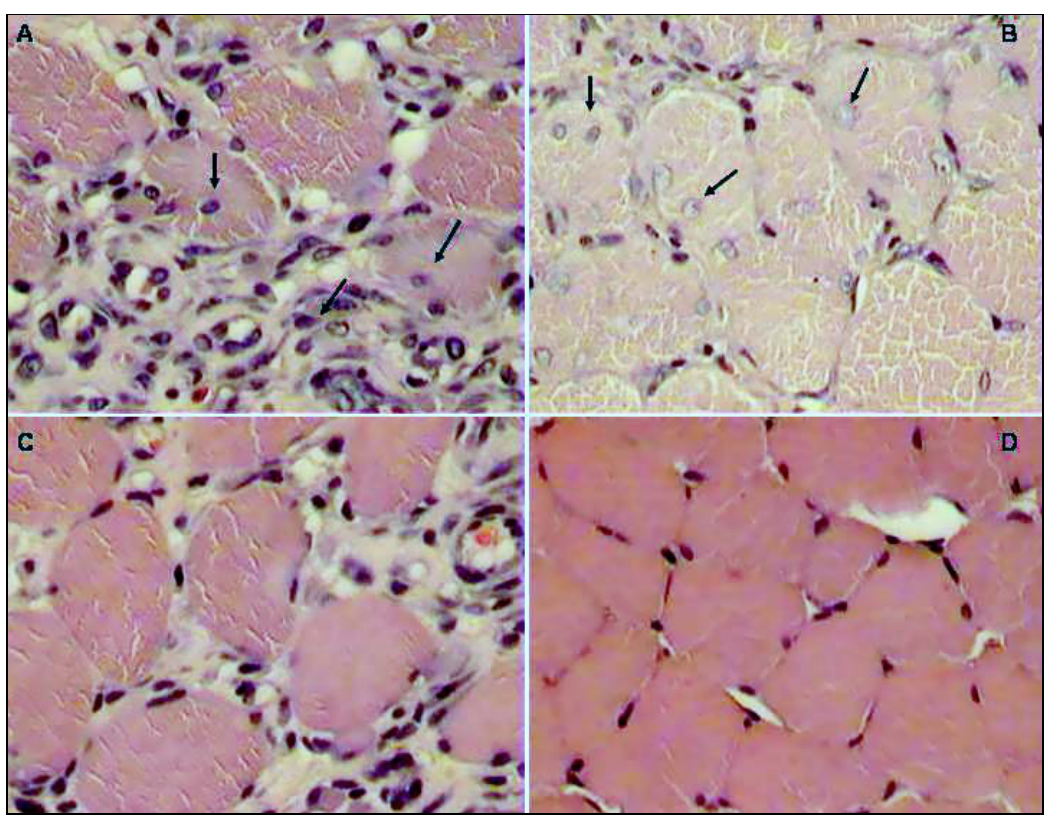
Figure 2. Cross-sections of gastrocnemius muscle ( A and B ) obtained at 3 days and 7 days following IM injection of B. moojeni venom at a dose of 40 µg/mL. In A and C